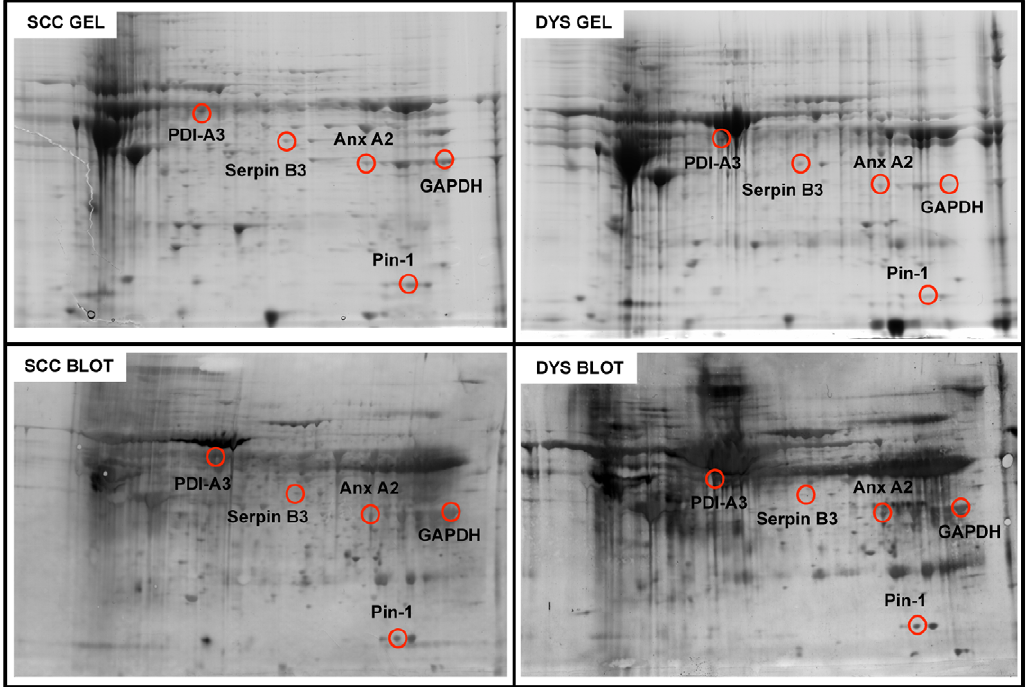
Figure 5. Oxidized protein detection by redox proteomics (DYS vs. SCC). Top: 2D gel maps of DYS (right) and SCC (left) cervical tissues. Protein (300 m g) were separated in first dimension (pH 3–10 linear IPG); second dimension was performed on slab gel (12% gradient SDS-PAGE). Protein detection was achieved using Biosafe Coomassie staining. Bottom: 2D carbonyl immunoblots of DYS (right) and SCC (left) cervical tissues. The spots showing significant increased carbonyl levels are labeled. Relative change in carbonyl immune-reactivity, after normalization of the immunostaining intensities to the protein content, was significant for five spots. The identified proteins are listed in table III.